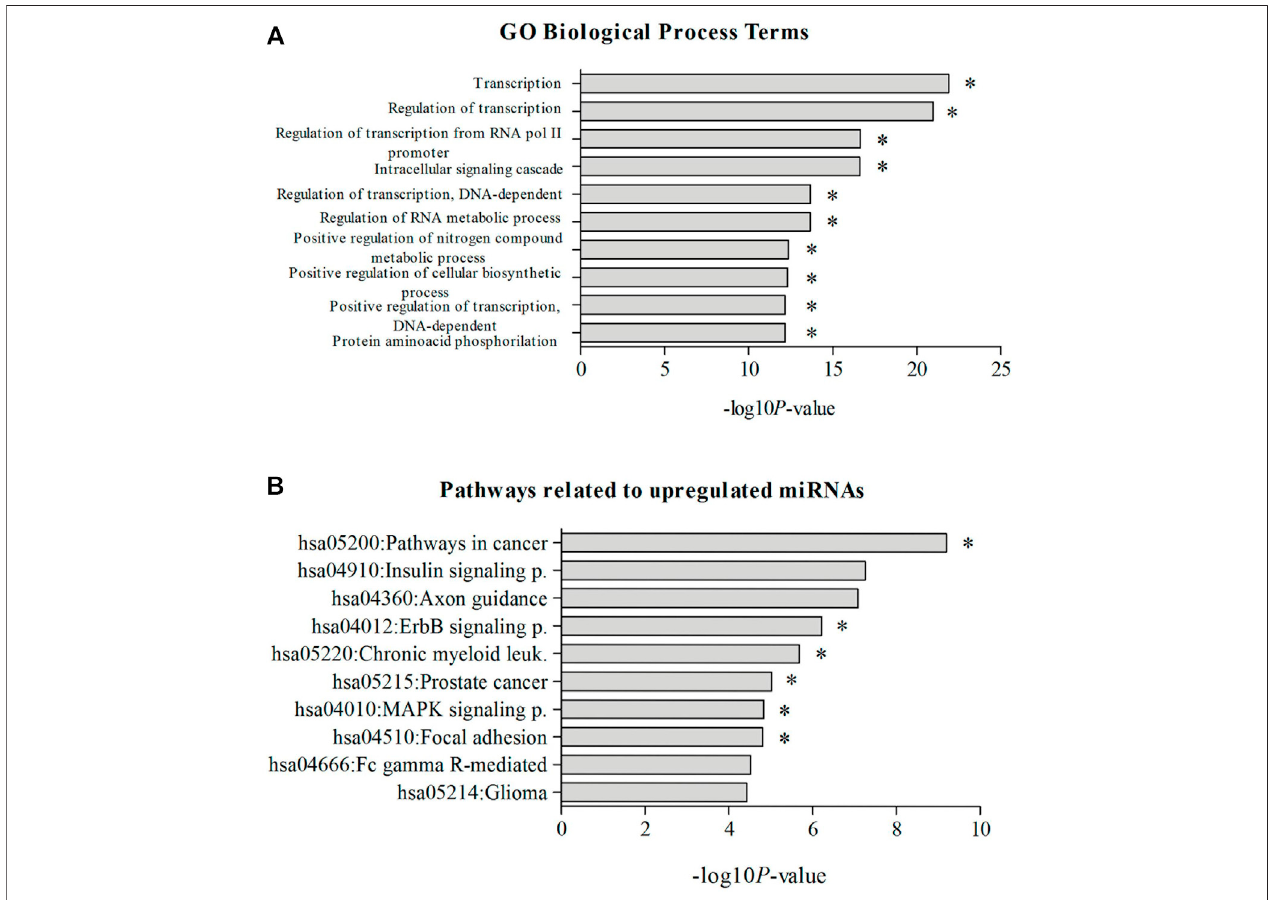
FIGURE 3 | Most signi fi cant KEGG pathways. (A) GO, biological process terms; (B) related to upregulated miRNAs in childhood in ALL patients with high sHLA-G levels. Note: *pathways containing genes coding for positive or negative regulators of HLA-G expression. KEGG pathway categories: hsa05200:Pathways in cancer, hsa04910:Insulin signaling pathway, hsa04360:Axon guidance, hsa04012:ErbB signaling pathway, hsa05220:Chronic myeloid leukemia, hsa05215:Prostate cancer, hsa04010:MAPK signaling pathway, hsa04510:Focal adhesion, hsa04666:Fc gamma R – mediated phagocytosis, hsa05214:Glioma. GO, biological